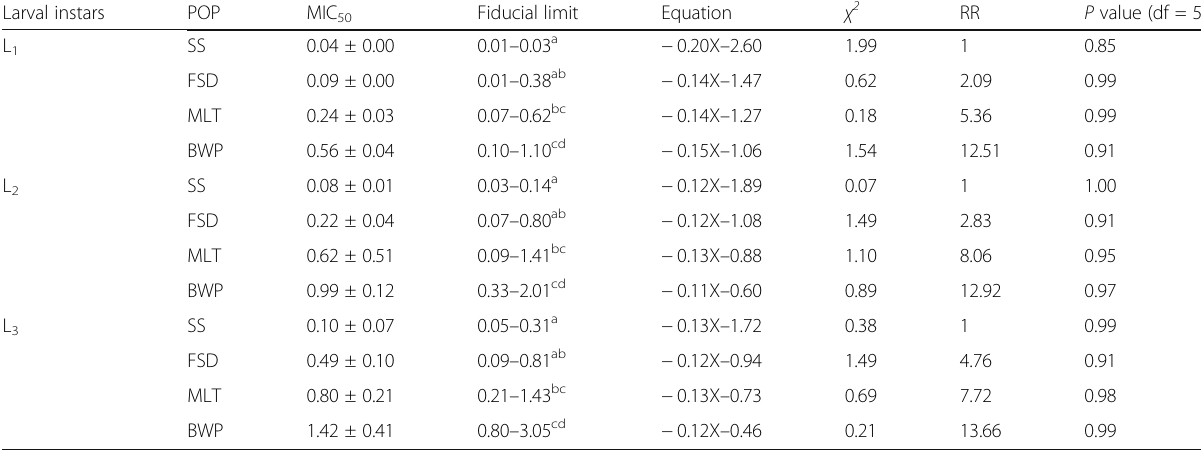
Table 2 Molt inhibitory concentration of susceptible and field population of Spodoptera exigua to Cry1Ac toxin during 2015 Larval